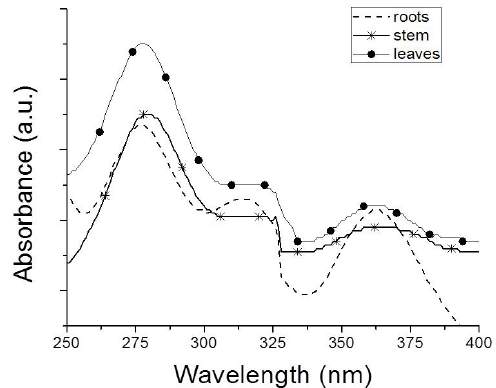
5 J Nanostruct 7(1): 1-12, Winter